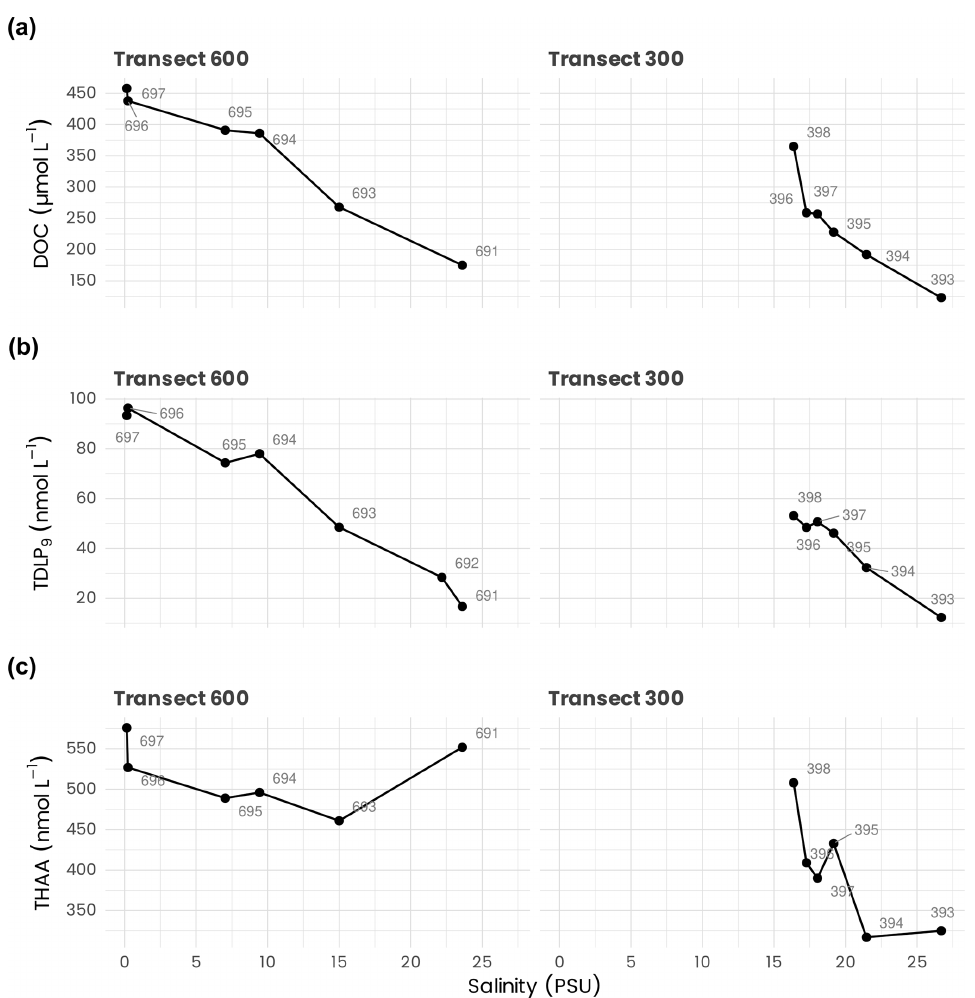
Figure 9. Surface concentrations of (a) dissolved organic carbon (DOC), (b) total dissolved lignin phenols (TDLP 9 ’s) and (c) total hydrolyz- able amino acids (THAAs) measured along transects 600 and 300 and plotted against